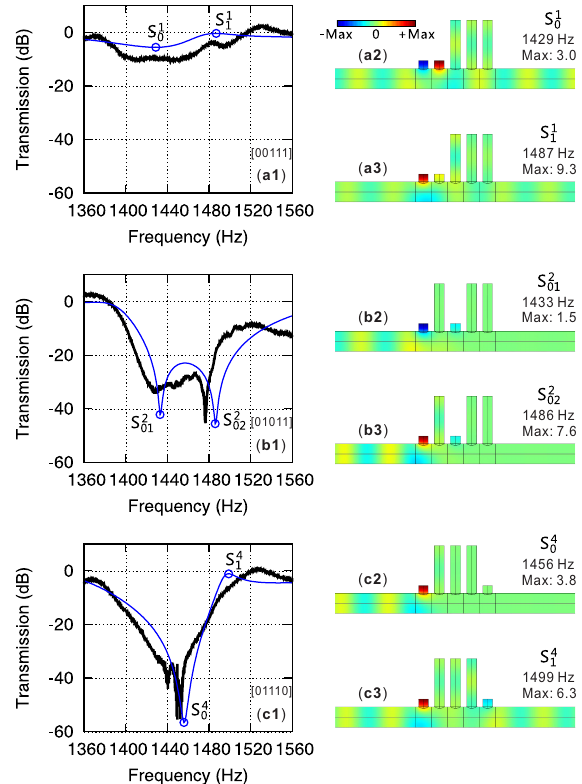
Figure 4. Transmission through a sequence of five short or long tubes grafted onto a waveguide with increasing separation between short tubes for ( a ) l = a ; ( b ) l = 2 a ; and ( c ) l = 4 a . Other dimensions are defined in Figure 1. Experimental (thick black line) and computed (thin blue line) transmission spectra around the fundamental resonance frequency of the short tube are shown on the left-hand side. Remarkable frequencies are labeled S α , with α = l / a indicating the normalized separation βγ between the two long tubes and β indicating either a transmission dip (0) or unit (1). If there are two transmission dips, they are identified using γ = 1,2. Normalized pressure distributions at the remarkable frequencies are shown on the right-hand side. For simplicity, we only display vertical cross-sections going through the symmetry axis of the waveguide. In each case, the frequency of the incident harmonic guided waves is shown on top. The color scale is for pressure normalized with respect to the maximum pressure